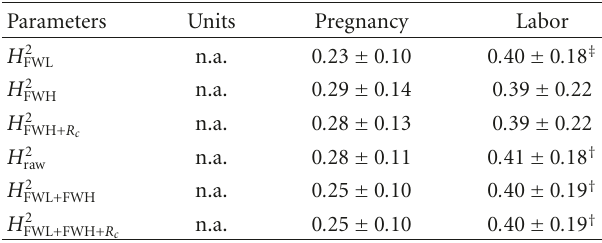
Table 5: Comparison of synchronization parameters ( H 2 ) between pregnancy and labor contractions ( † and ‡ indicate a significant di ff erence of 5 and 1%, respectively between pregnancy and labor parameters).